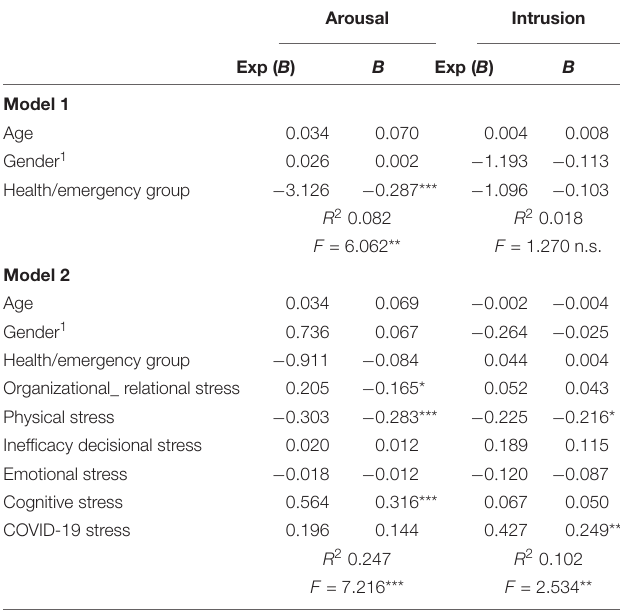
TABLE 4 | Hierarchical regressions on Arousal and Intrusion ( n =